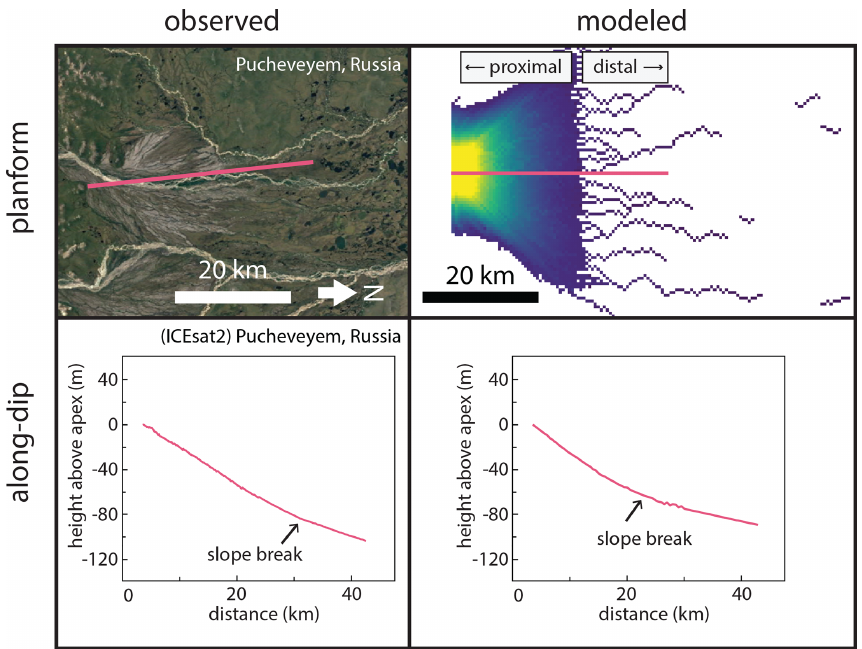
Figure 5. Megafan topography from model output compares favorably with real megafans, including delineation into distinct domains of slope. Color bar and explanation for modeled planform is provided in Fig. 6. Satellite images are USGS/NASA Landsat/Copernicus, © Google